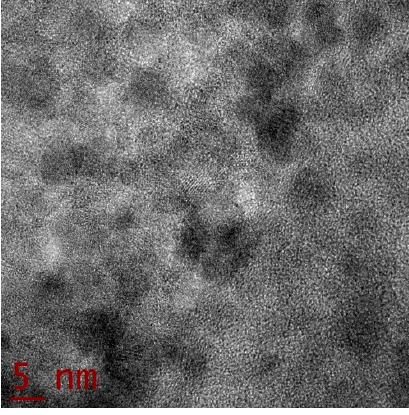
Figure 3. Representative HRTEM micrograph of a region of the studied thin solid film sample showing the Au NPs in dark color.